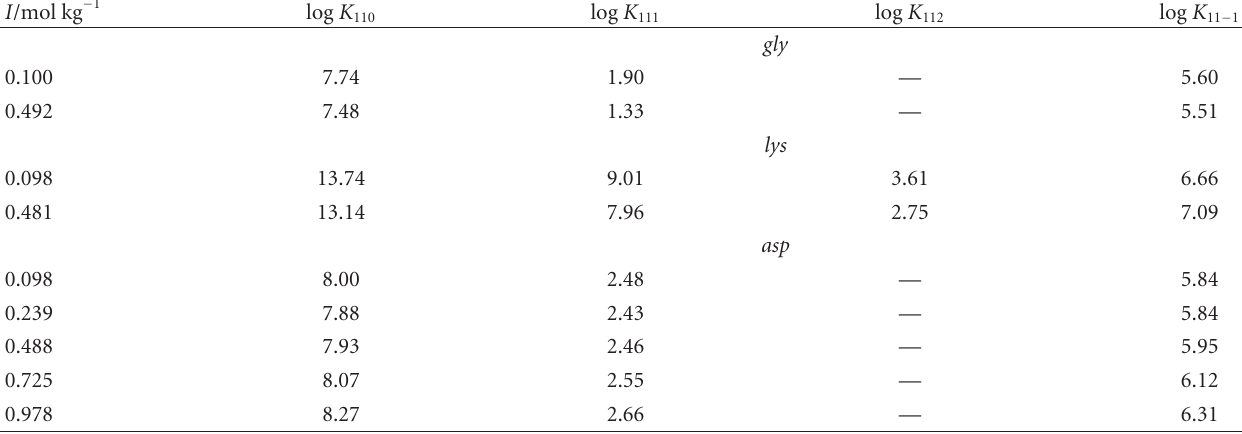
Table 7: Stability constants of dimethyltin(IV)/aminoacid species, in NaCl aq at di ff erent ionic strengths (in mol kg − 1 H 2 O), and t = 25 ◦ C. log K pqr refer to equilibria reported in